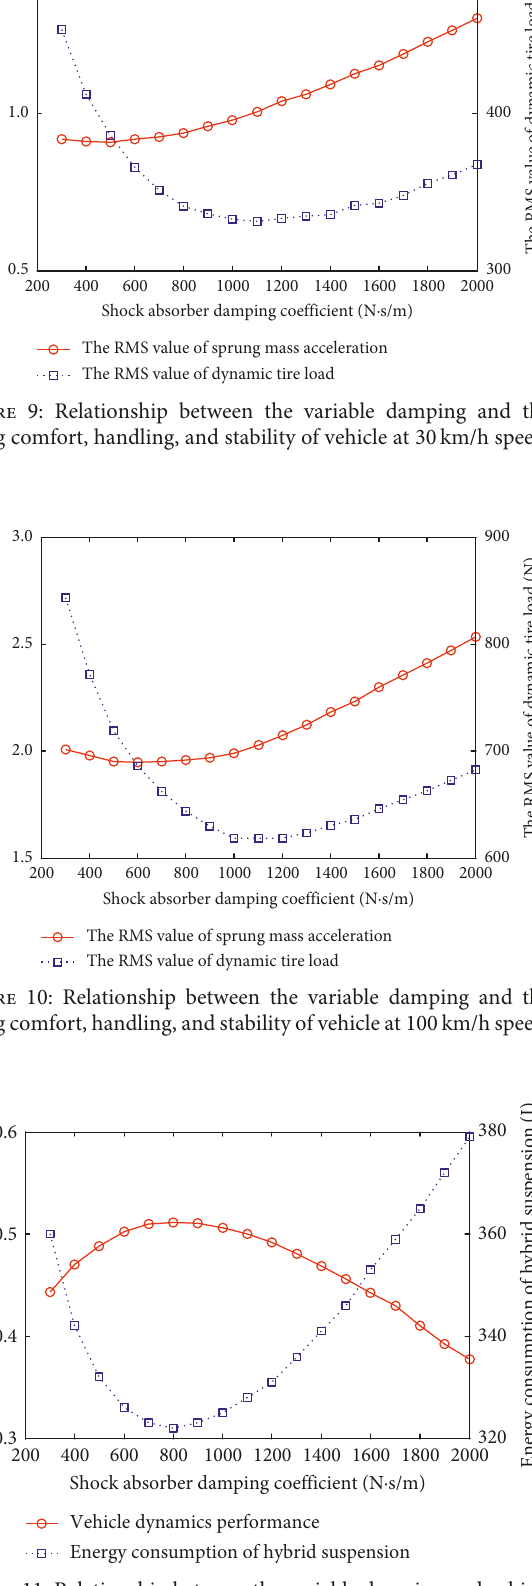
Figure 11: Relationship between the variable damping and vehicle dynamic performance at 30km/h speed.